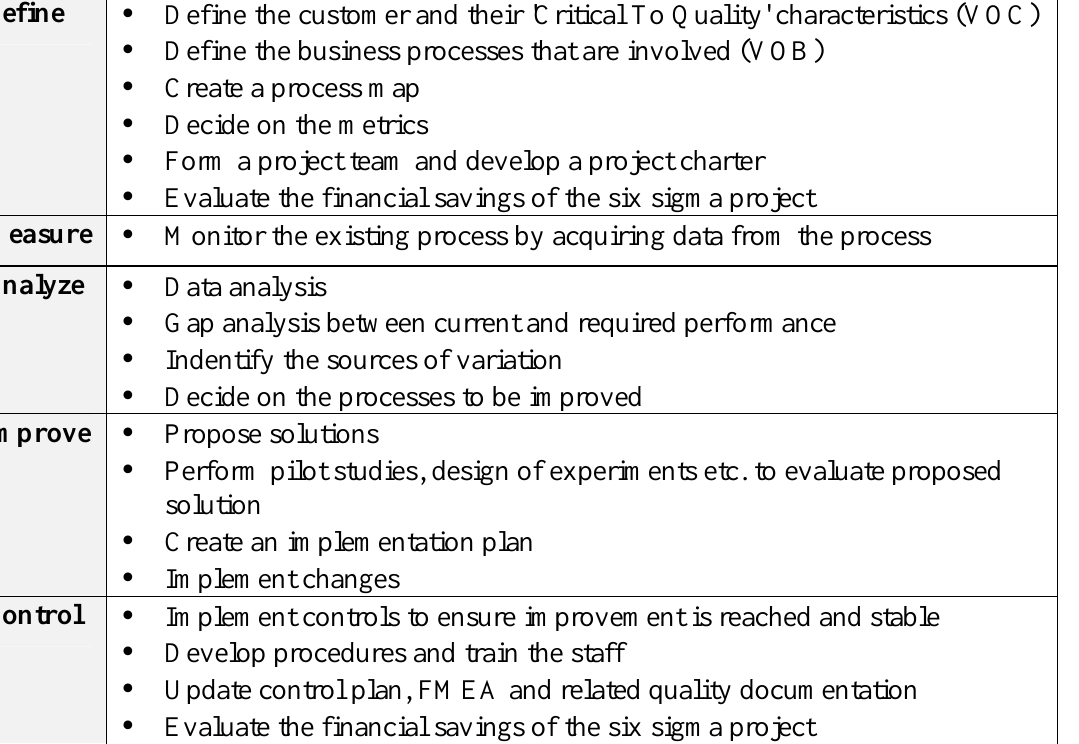
Table 1 – DMAIC structure of Six Sigma strategy